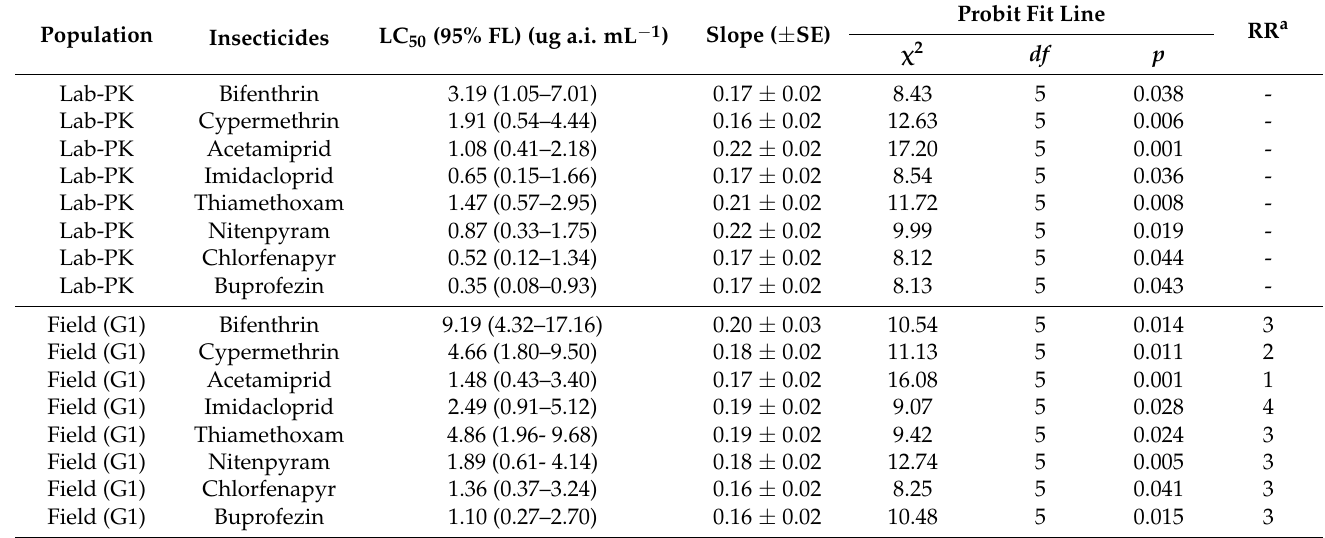
Table 2. The response of laboratory susceptible (Lab-PK) and field population of B. tabaci against different insecticides.